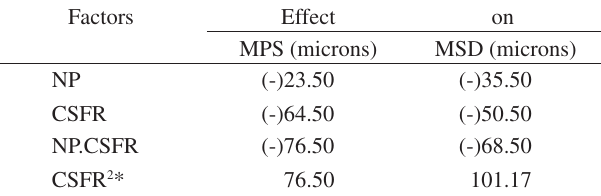
Figure 5. a) Predicted and observed values for model Y ameter ( µ m); and b) Predicted and observed values for model Y deviation ( µ m).